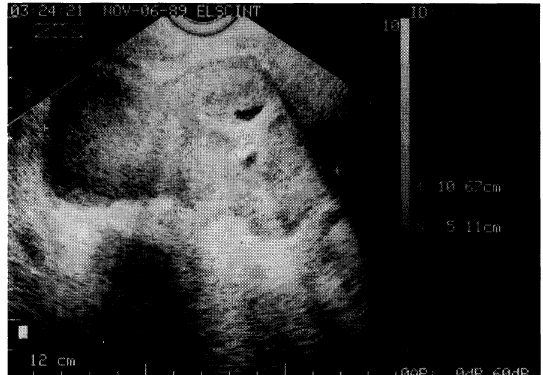
Fig. I. Transvaginal sonogram of the actinomycosis pelvic